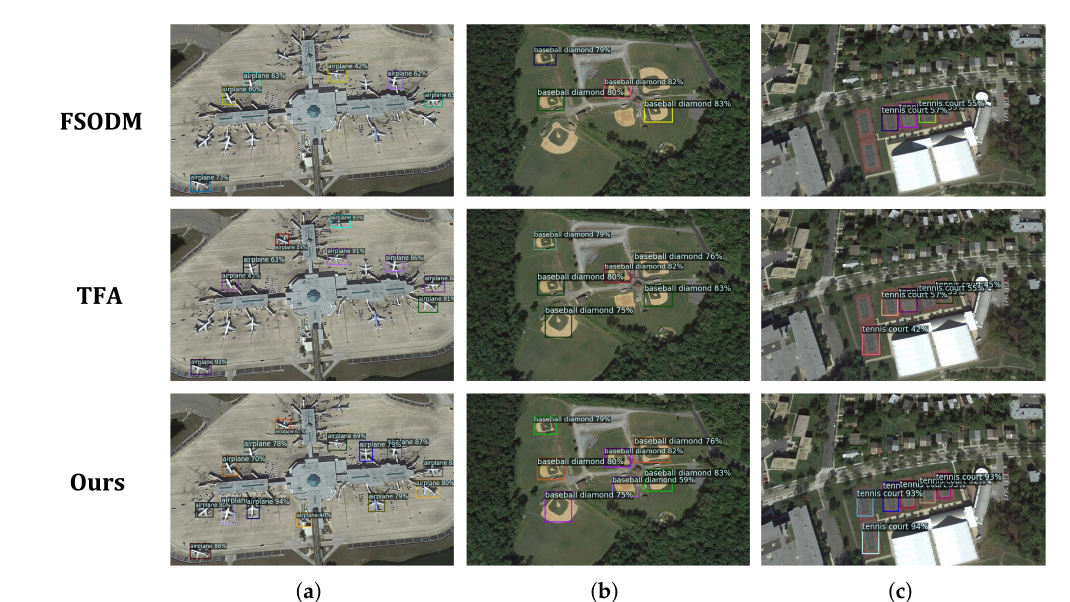
Figure 9. Qualitative inference results of novel categories on the NWPU VHR-10 dataset. ( a ) airplane,